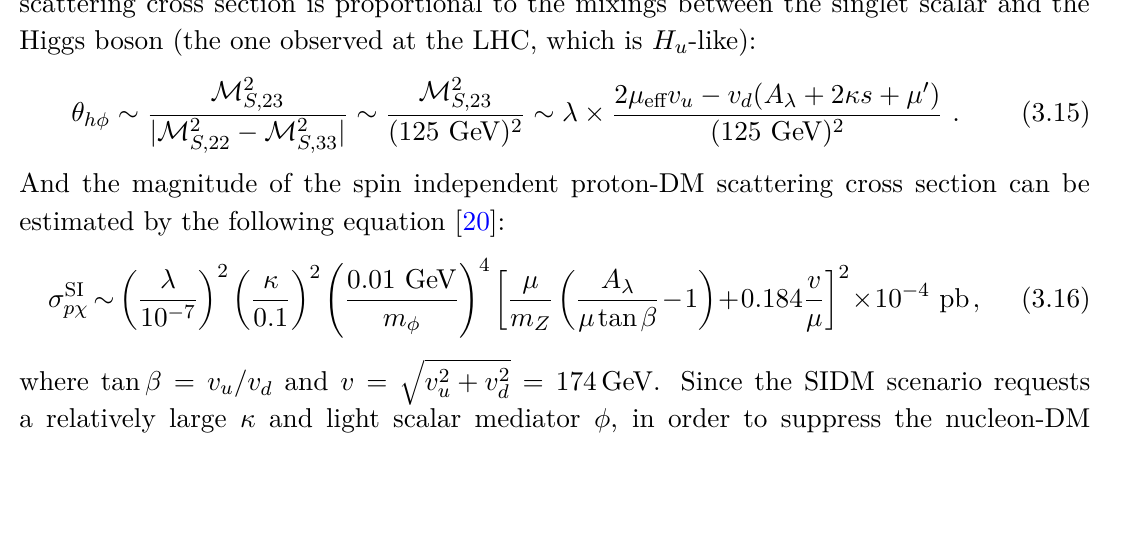
is 0.01 GeV and smaller, which φ to make Ω h 2 = 0 . 12 according to eq. χ